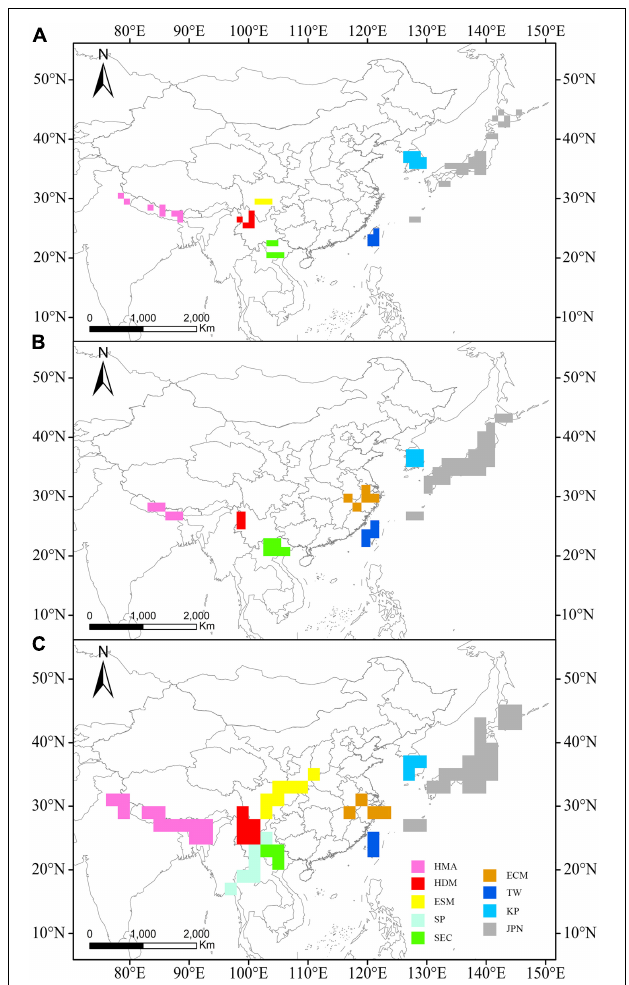
FIGURE 5 | AOEs obtained for Lycocerus by PAE using three different grids by the global scale: (A) 1 ◦ grid size, (B) 1.5 ◦ grid size, and (C) 2 ◦ grid size. Different colored shadows denote different AOEs: purple (HMA), red (HDM), light blue (SP), yellow (ESM), green (SEC), brown (ECM), dark blue (TW), sky blue (KP), and gray